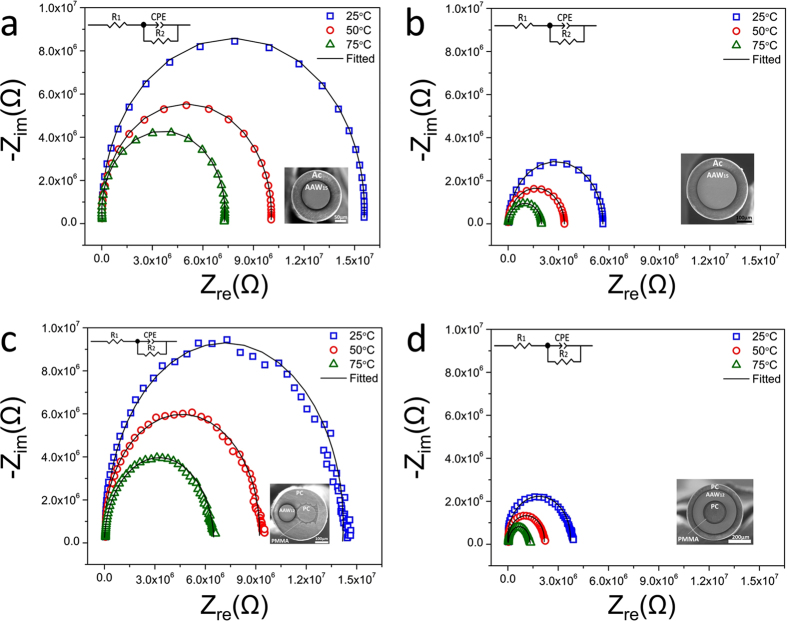
Nyquist spectra for: (a,b) the 125 μm and 250 μm diameter single-core AAW15 glass fibers with acrylic coating (Ac); (c) the dual-core fiber with 125 μm AAW12 glass and 140 μm diameter PC cores and (d) the ring-core fiber with a PC cladding ring of 45 μm thickness, an electrically conductive AAW12 glass ring of 90 μm thickness, a PMMA ring of 25 μm thickness, and a PC core of 155 μm diameter. Fiber length: 15 cm. Glass labels: AAW12: 45AgI-43-AgPO3-12WO3, AAW15: 45AgI-40-AgPO3-15WO3.